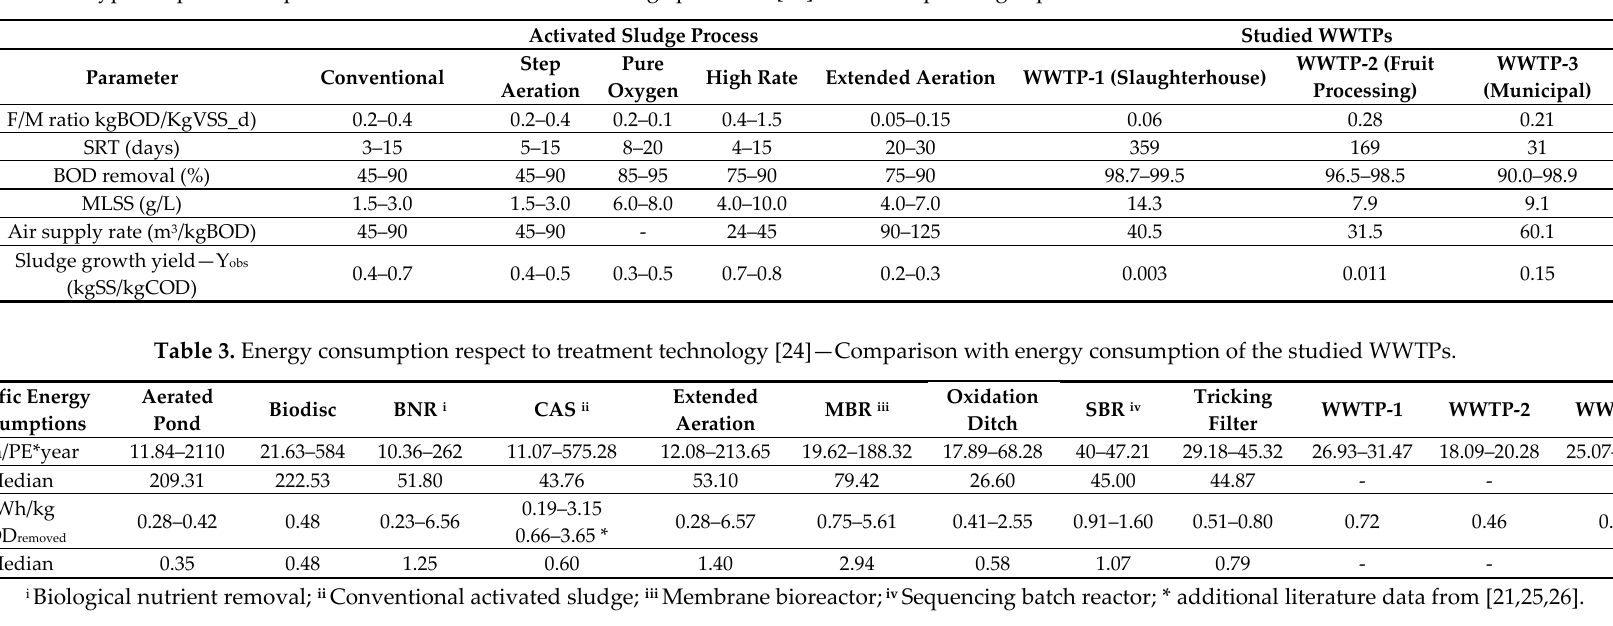
Table 2. Typical operational parameters in various activated sludge processes [23] and corresponding experimental values at the three WWTPs studied.